Question: Summarize what this figure shows in one sentence.
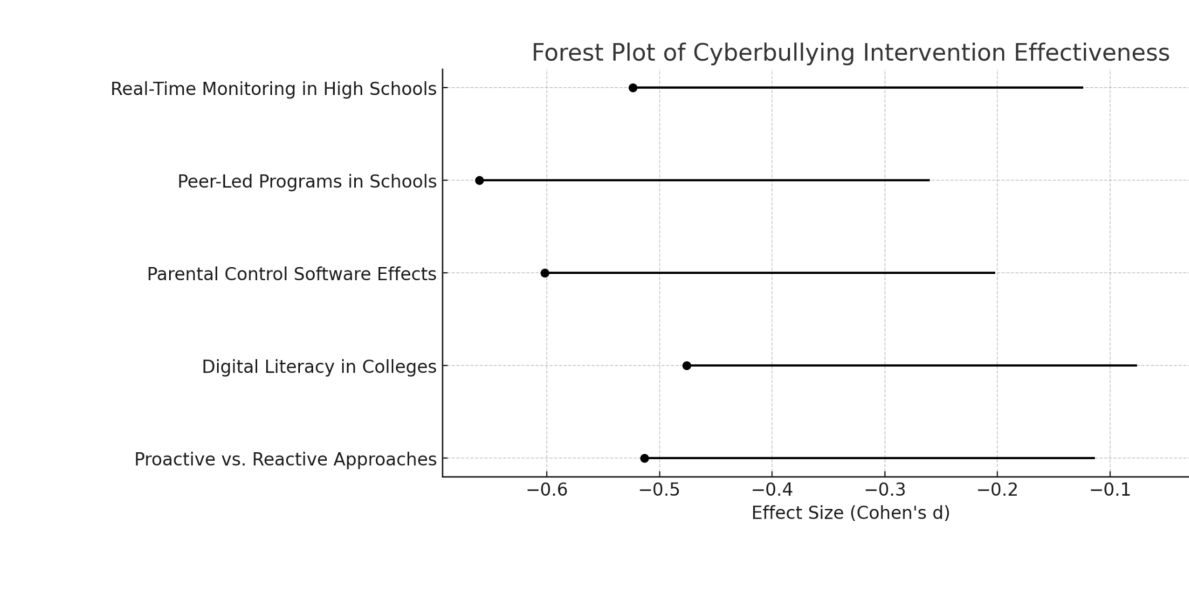
Answer: Forest plot of cyberbullying intervention effectiveness